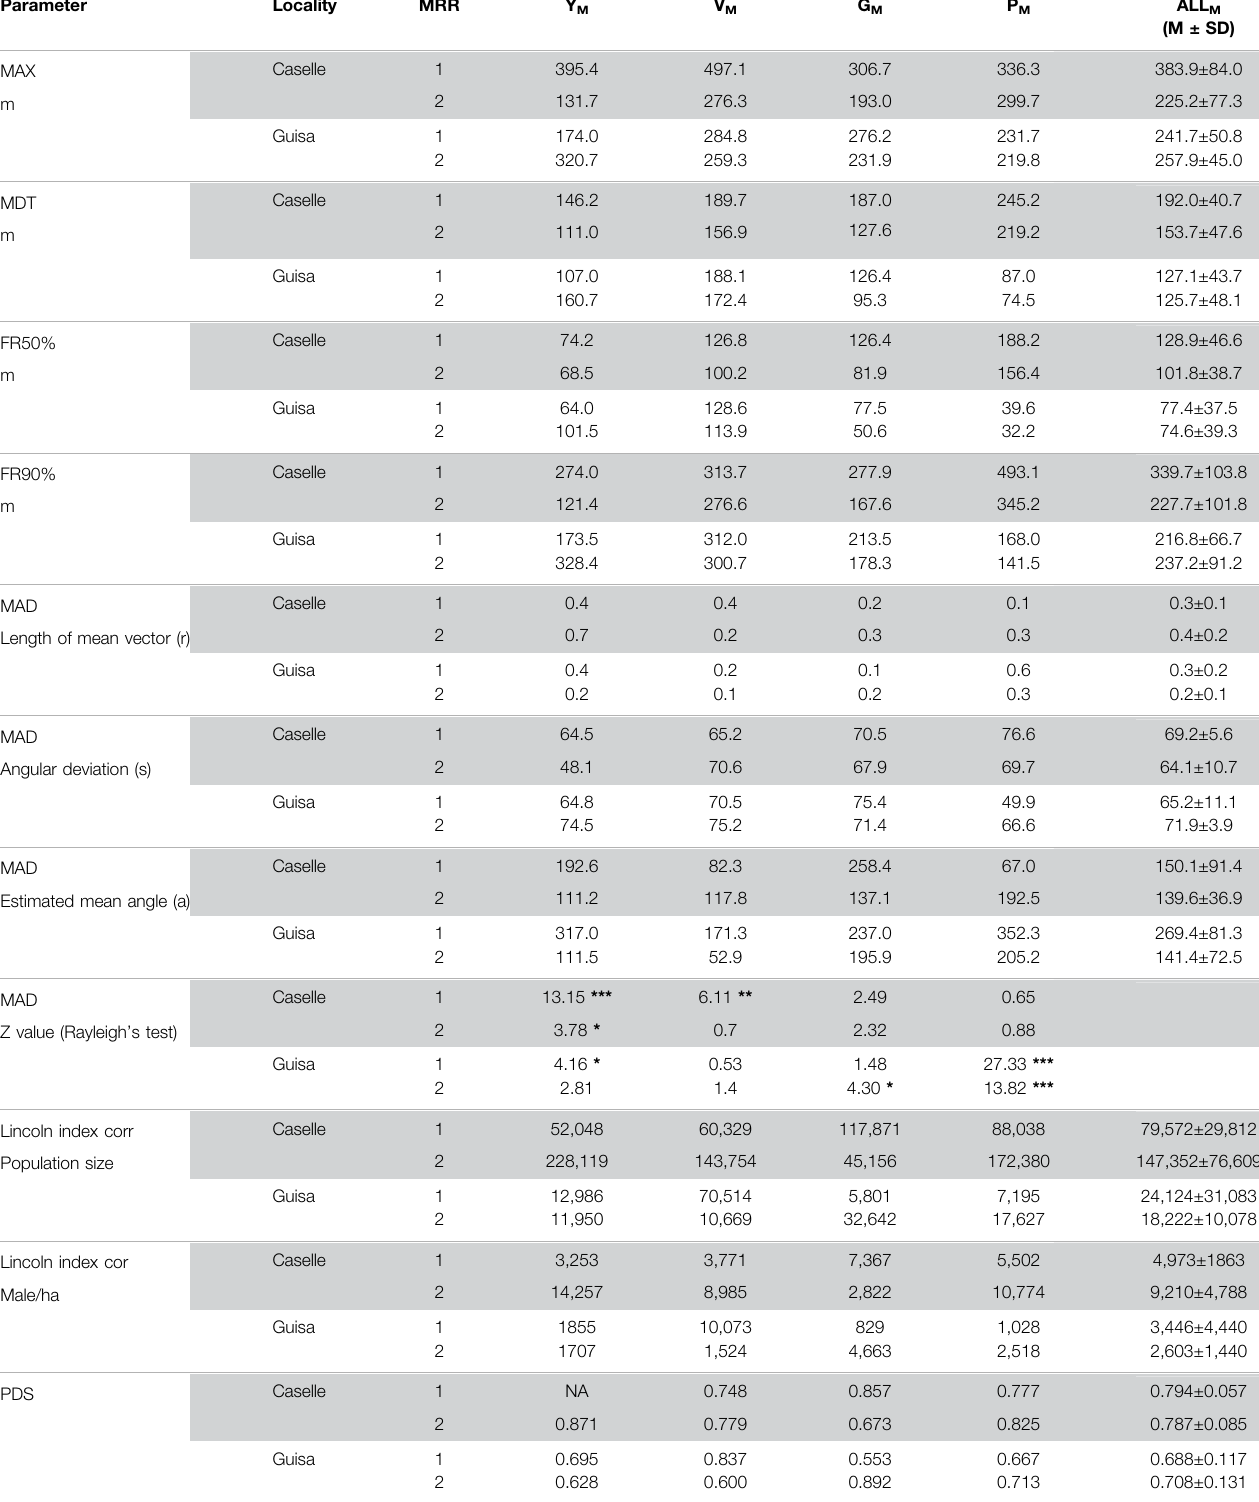
TABLE2| DispersionandsurvivalparametersregisteredinthetwoSITlocalitiesofCaselleandGuisaPepoliinthe fi rstandsecondMRRtrials. MDT ,meandistancetraveled; MAX ,maximumdistancetraveled; FR50% and FR90% ,maximum fl ightdistancereachedby50%and90%oftheindividuals; MAD ,meanangleofdispersion(r,lengthof dispersion; s, angular deviation; a, estimated mean angle; Z value, Rayleigh ’ s test); Lincoln index - corrected P indicates the population size expressed in number of male/ha; PDS , probability of daily survival; ALE , average life expectancy (day); Θ , the recapture rate; S , the survival rate. * p < 0.05, ** p < 0.001, *** p < 0.0001.